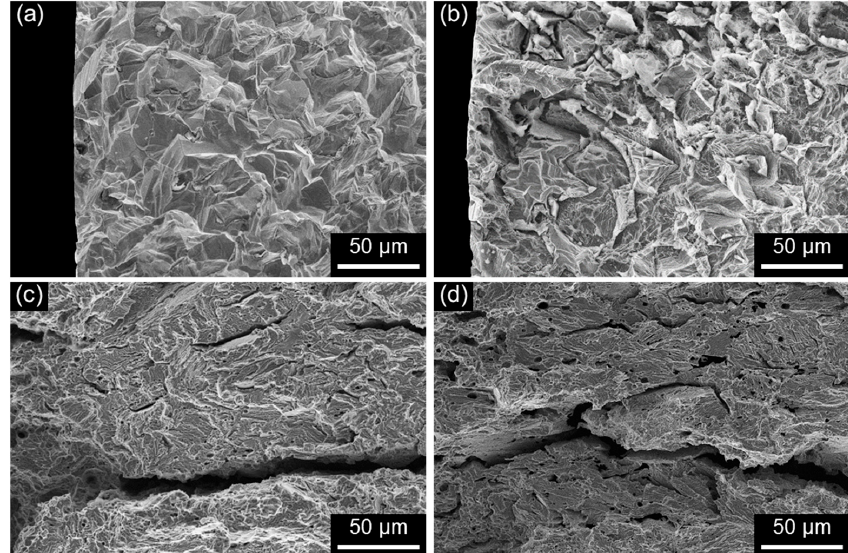
Figure 10. SEM micrographs of the crack initiation sites of ( a , b ) D1 and ( c , d ) D2 alloys after the SSRT conducted in 2 M NaCl solution at 50 °C under anodic applied potential of +0.05 V versus E corr at a strain rate of 10 − 6 s − 1 . The SSRTs were conducted along ( a , c ) L- and ( b , d ) T-directions.